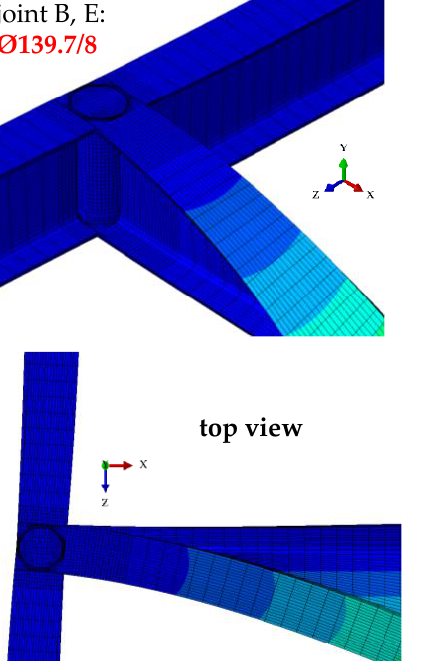
Figure 8. Bimoment deformations of B joint of H-grillage obtained with Abaqus: ( a ) closed-section stiffener Ø139.7/8, ( b ) flat stiffener t p = 8 mm.